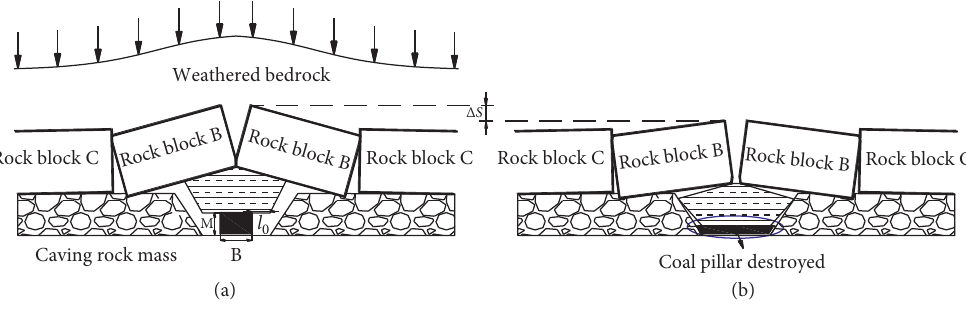
Figure 8: (a) Coal pillar is not destroyed; (b) coal pillar is destroyed.